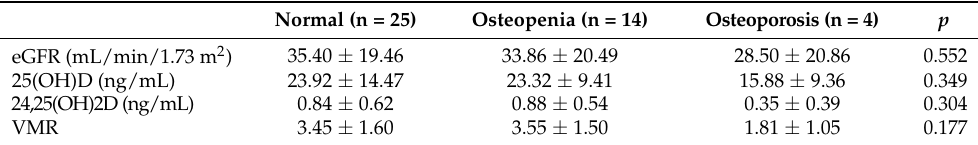
Table 4. Vitamin D biomarkers according to the results of bone